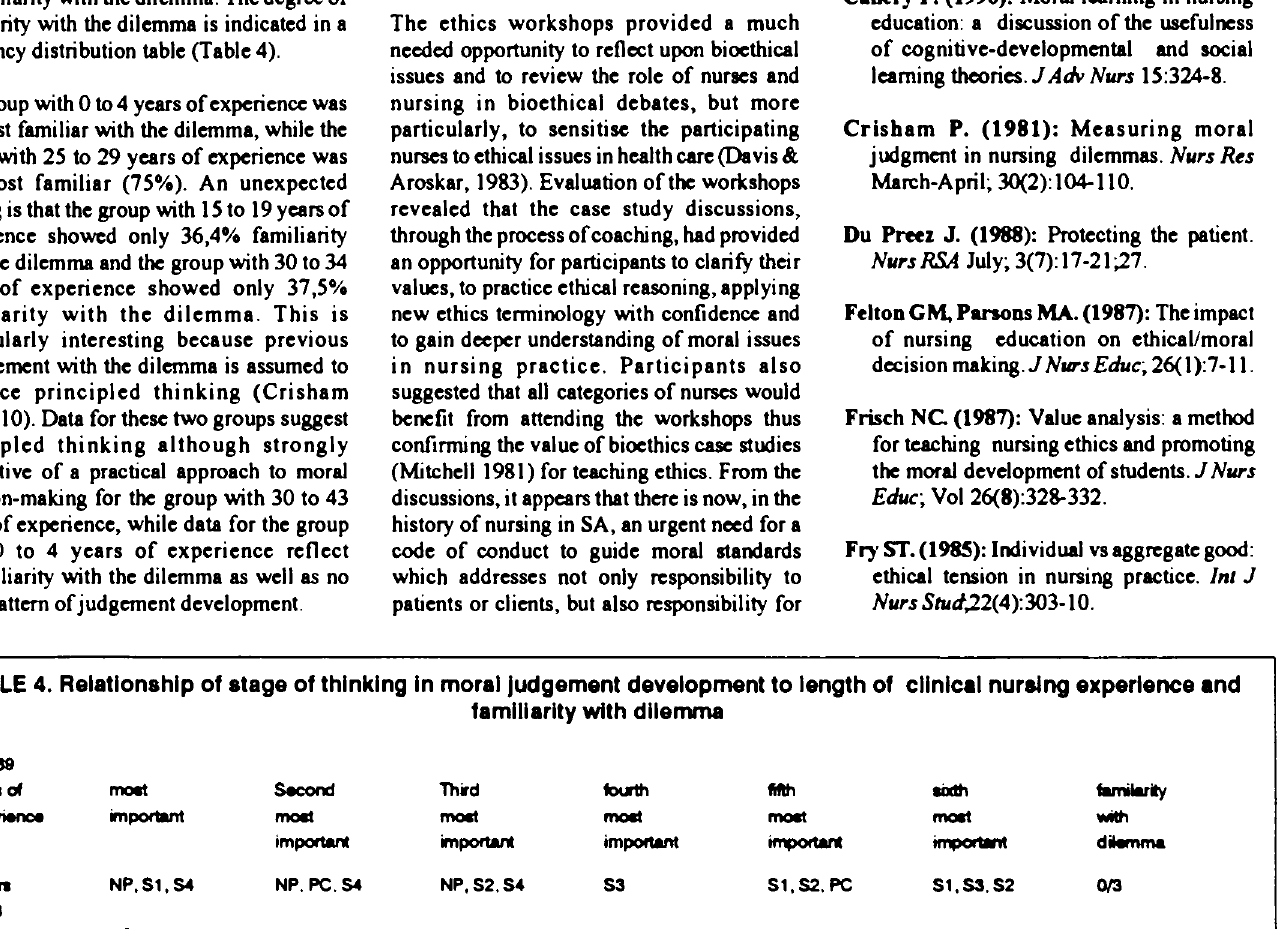
TABLE 4. Relationship of stage of thinking in moral judgement development to length of clinical nursing experience and familiarity with